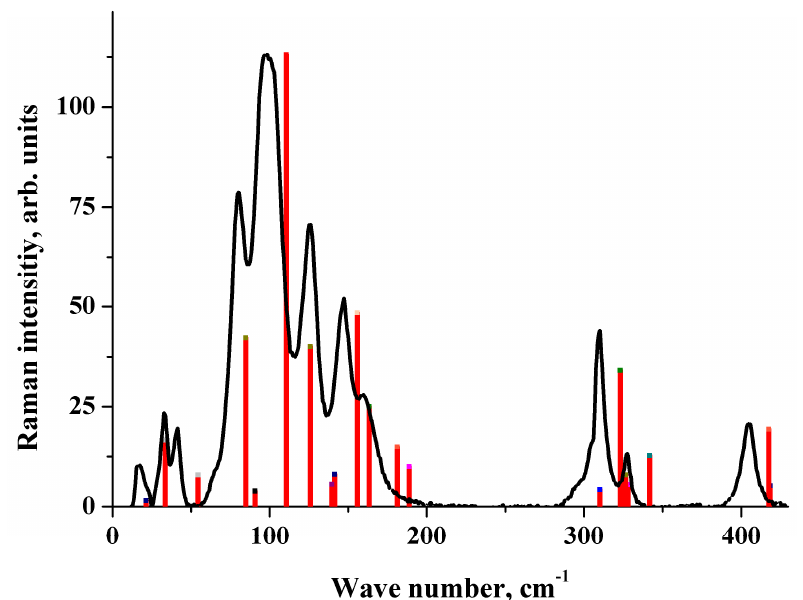
Figure 4. Raman spectrum of crystalline maleic acid. Experiment (black line) vs. B3LYP(AtomOnly) computations (red bars). The height of the bars is proportional to the relative Raman intensity of the corresponding transition.